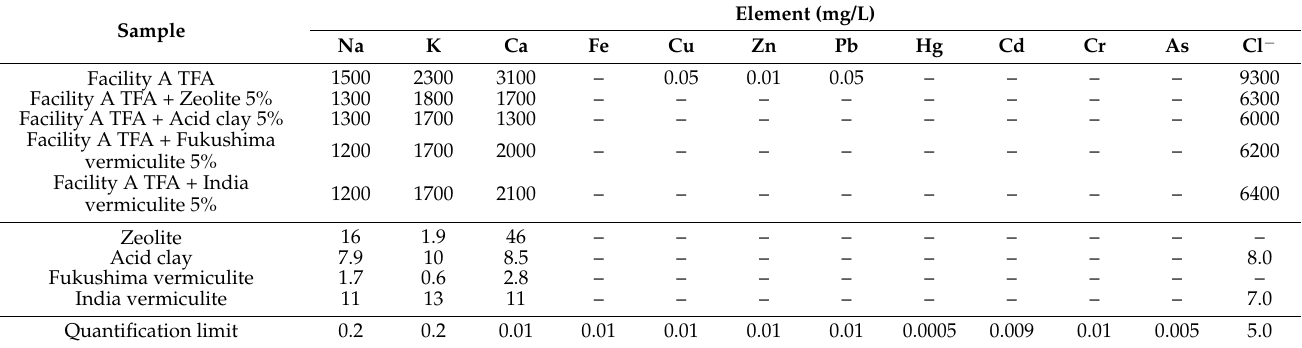
Table 13. Leaching test results indicating the effect of clay minerals on the chelating effect (30 d).